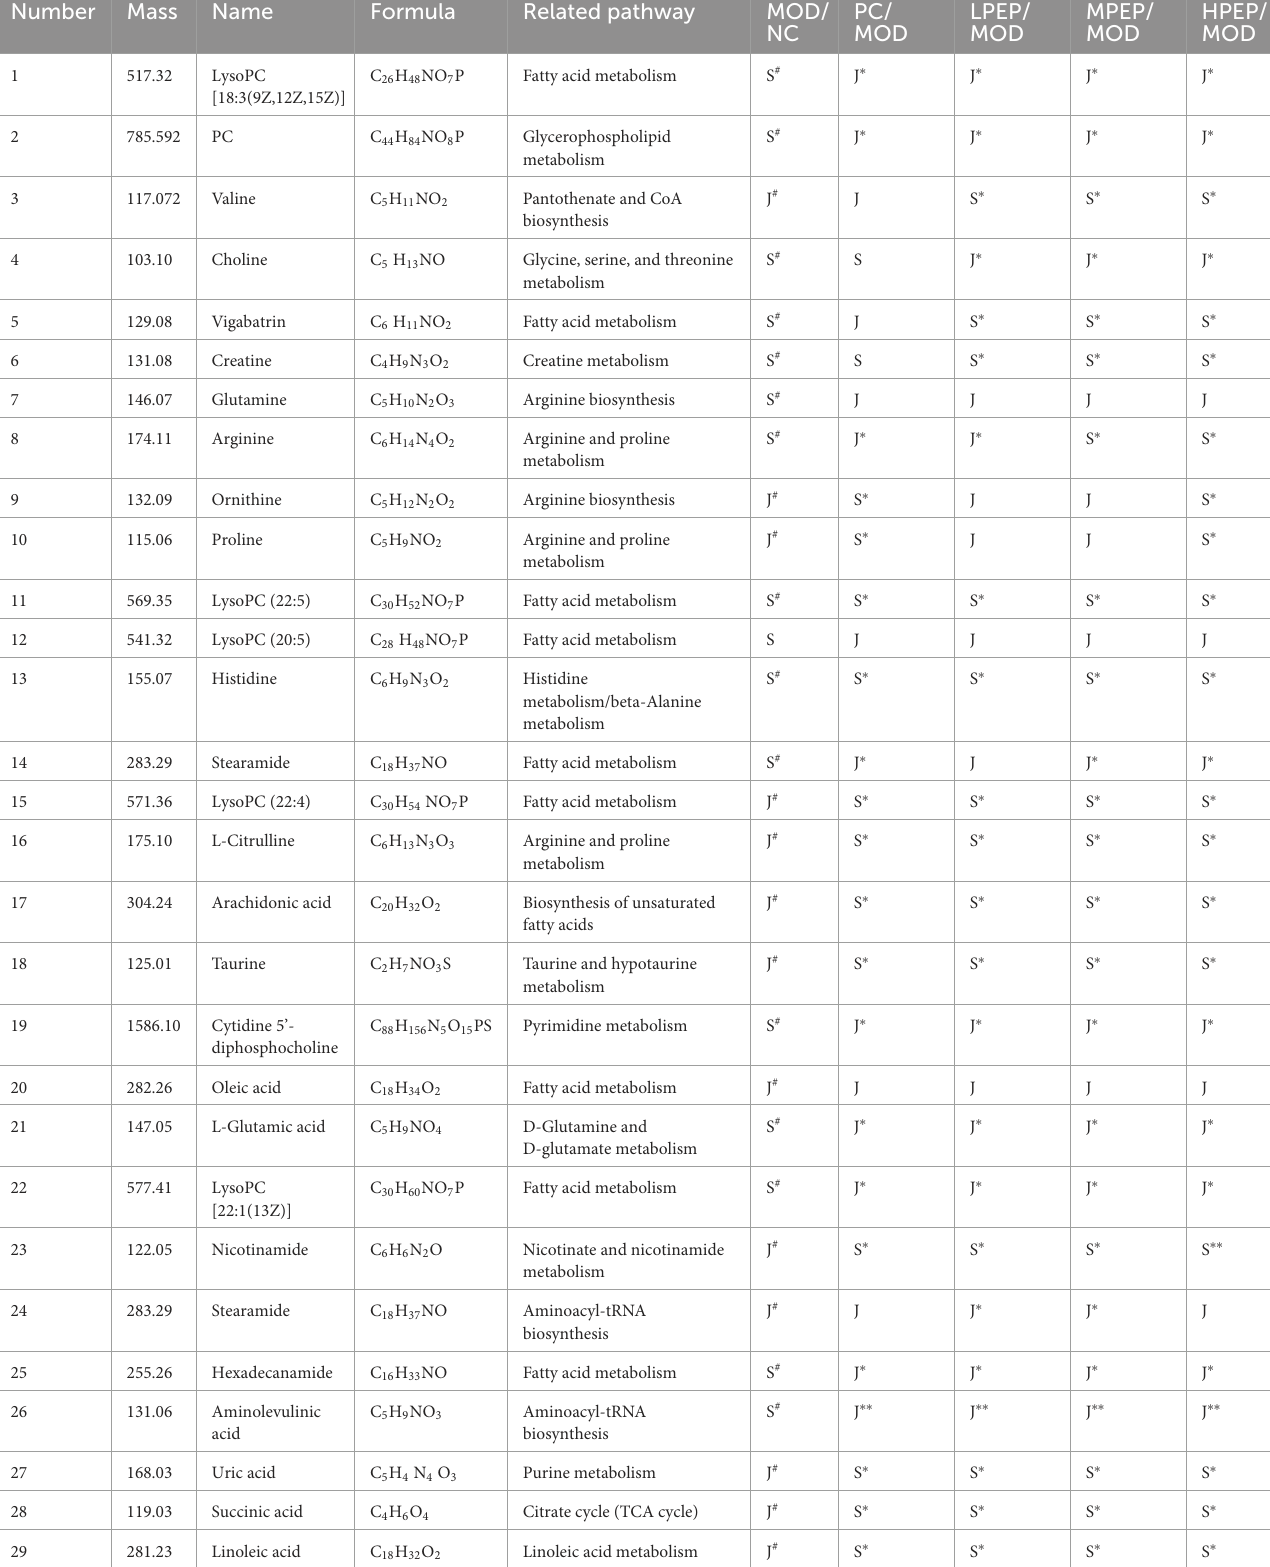
TABLE 1 Results of serum metabolite analysis in positive ion